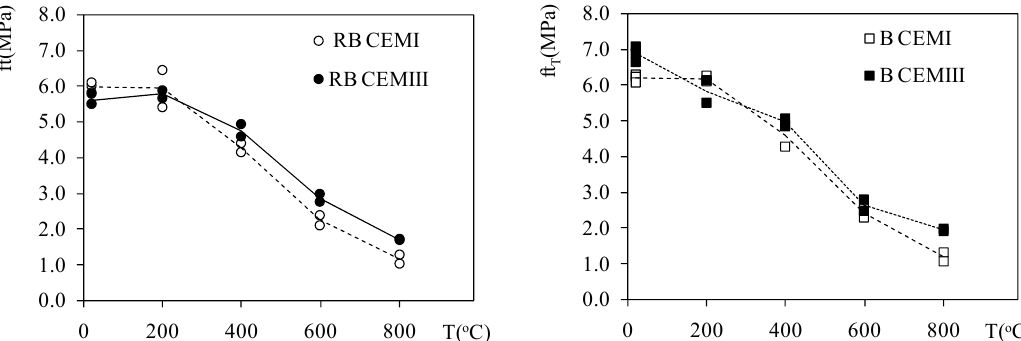
Figure 4. The changes in the splitting tensile strength of heated CEMI and CEMIII concretes on basalt and riverbed aggregate.